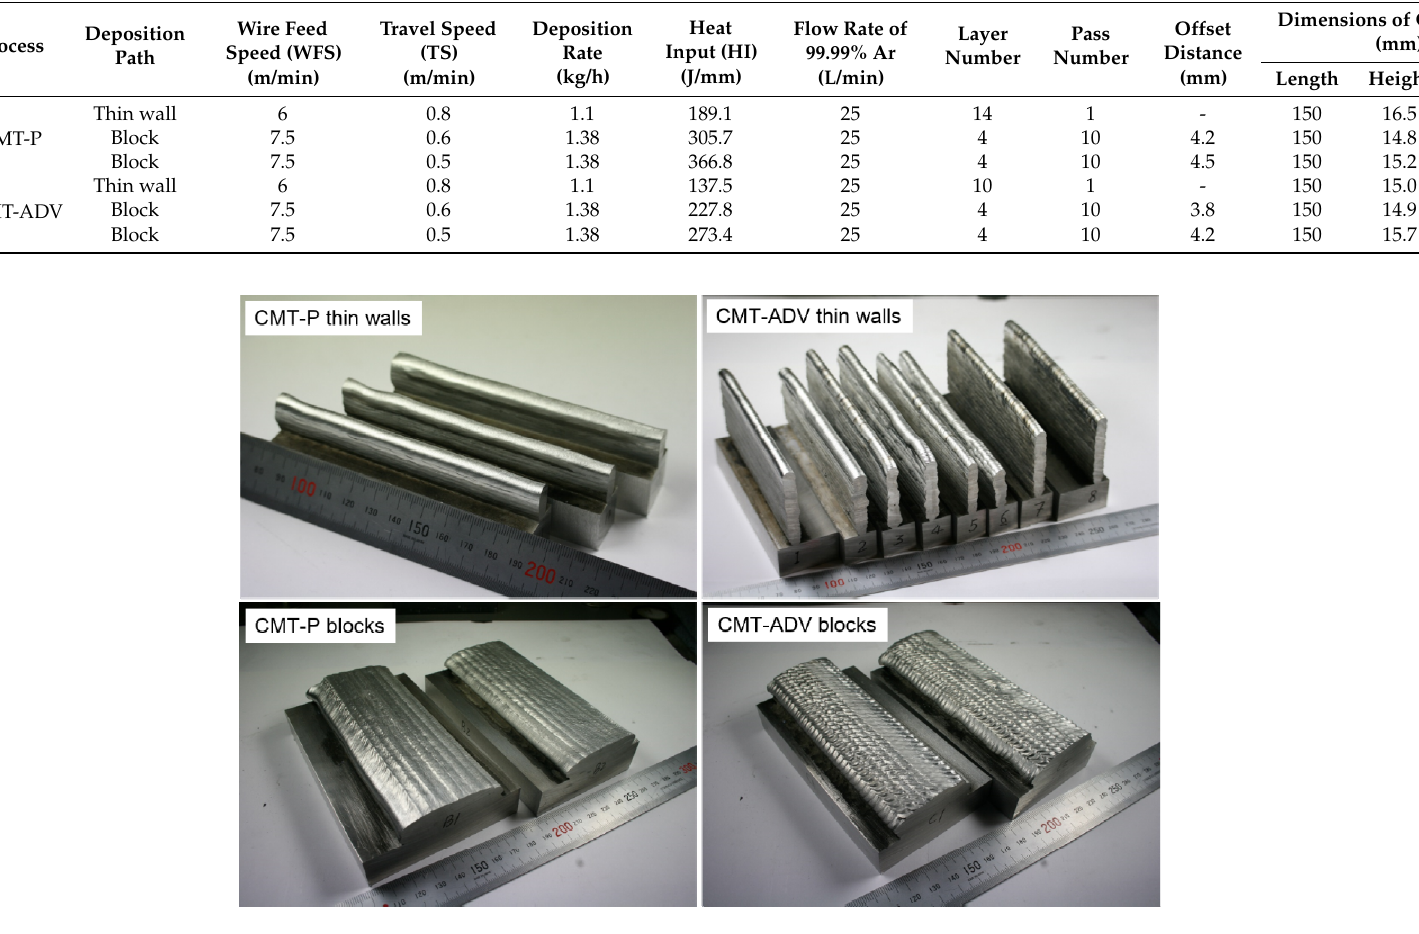
Figure 4. Wire + arc additive manufactured aluminum alloy structures.